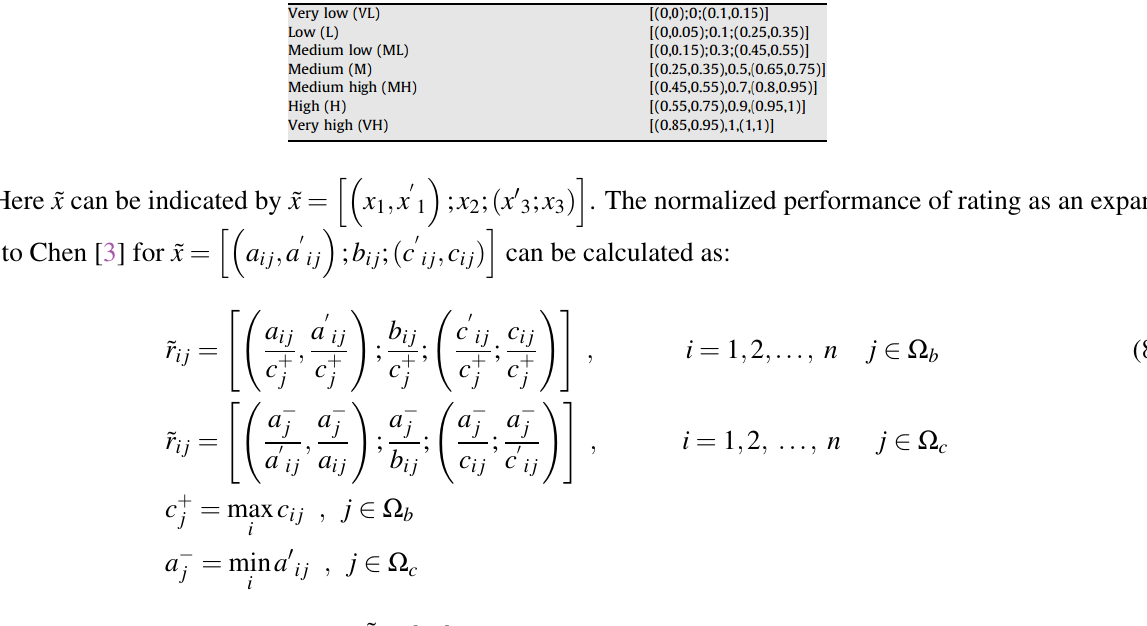
Table 2 Definition of linguistic variables for the importance of each